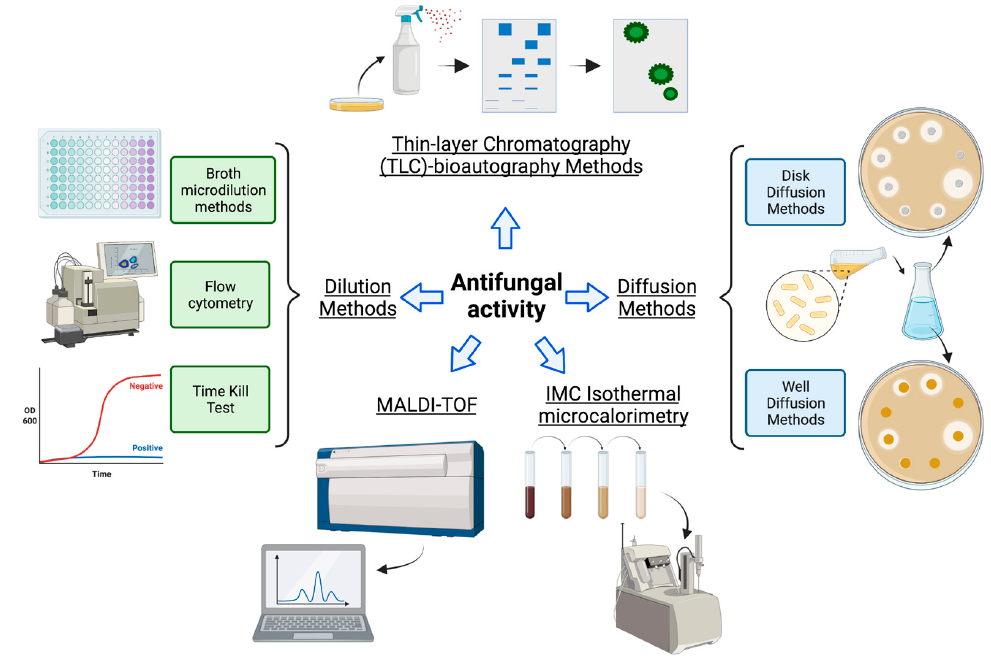
Figure 2. Summary of the principal methods used to evaluate antifungal activity; MALDI-TOF: matrix-assisted laser desorption/ionization-time of flight; OD: optical density.